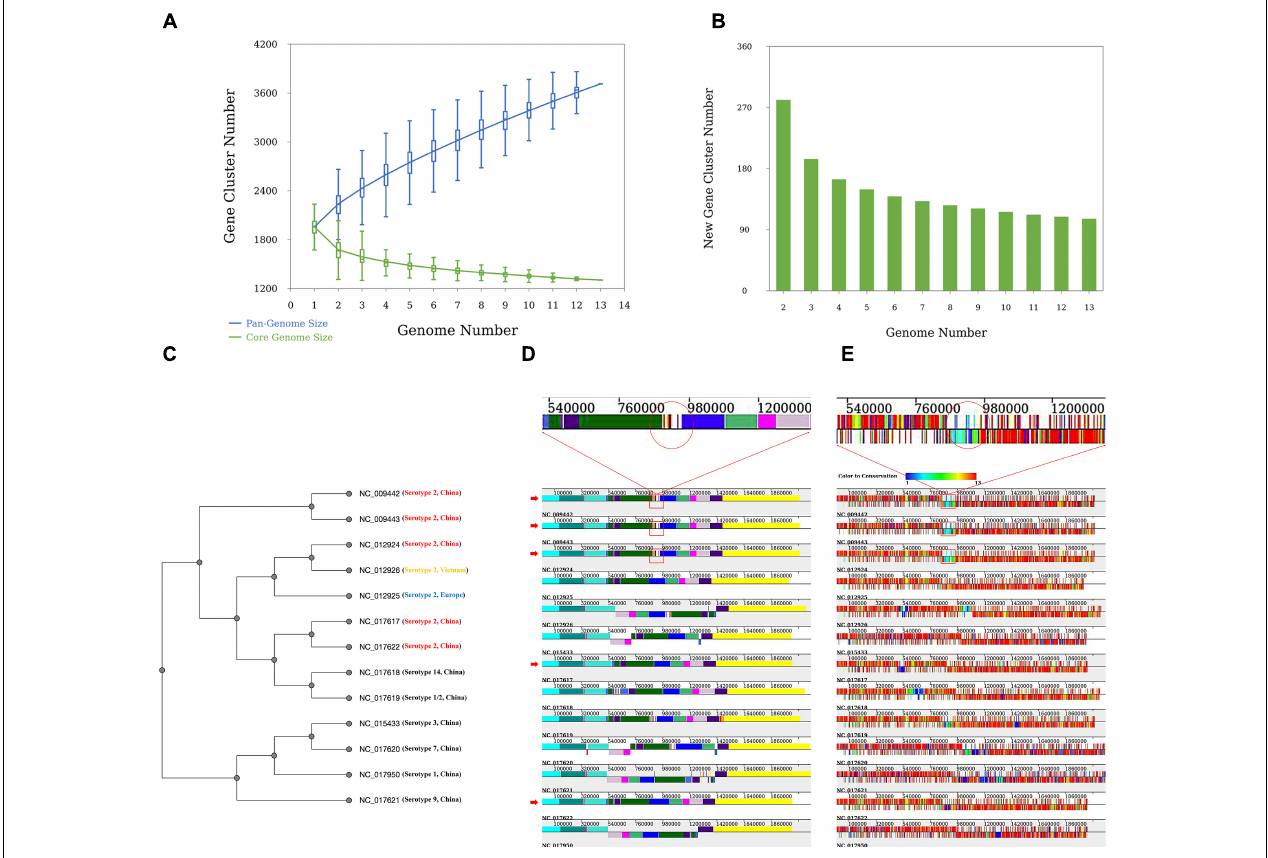
FIGURE 3 | Results of the case study. (A) Pan-genome profiles of 13 Streptococcus suis strains. Pan- and core-genome size prediction with all combinations of studied strains. (B) New prediction happens when an additional genome is introduced. (C) Phylogenetic tree based on UPGMA built from 13 S. suis genomes. All strains are labeled with serotype and place of origin. All Chinese serotype two strains are marked in red, Vietnamese serotype two strains in yellow, and European serotype two strains in blue. (D) Alignment result of 13 S. suis genomes. The red arrow indicates Chinese serotype 2 S. suis strains. Red rectangles indicate the ∼ 89-kb PAI (candidate pathogenicity island) proposed by Chen et al. (2007). (E) Orthologous gene distribution of 13 S. suis genomes. Different colors represent degrees of conservation for each gene (PGAP-X).